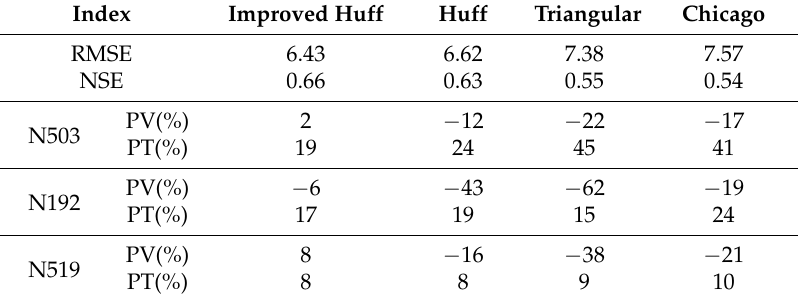
Table 6. Mean RMSE and NSE values between the 71 observed hyetographs at Site 1 and their design storms, and the mean relative difference of the simulated peak flooding volume (PV) and time (PT) at the three nodes by the design storms against those simulated by the 71 observed storms at Site 1. All design storms are computed using the parameters derived from the 104 storms at Site 2, together with the total rainfall depth and duration for each storm at Site 1. Index Improved Huff Huff Triangular Chicago